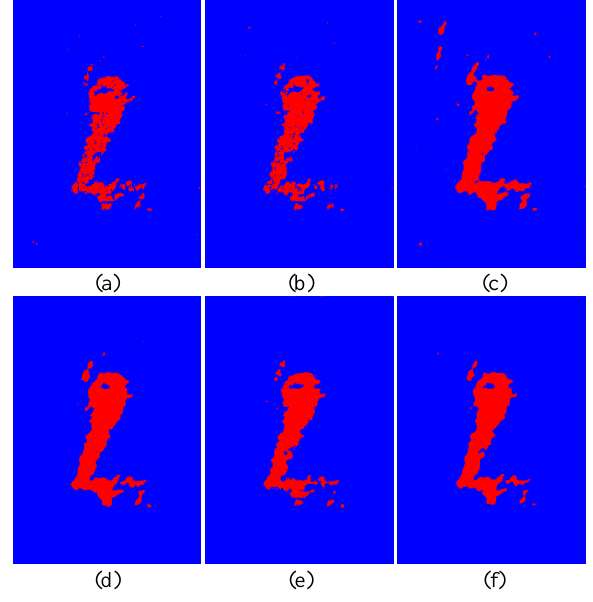
Figure 6. K-means classification of six polarimetric features in SIR-C Pr44327 images. (a) Dop ; (b) μ ; (c) A 12 ; (d) Ph ; (e) V ; (f) rrr s .